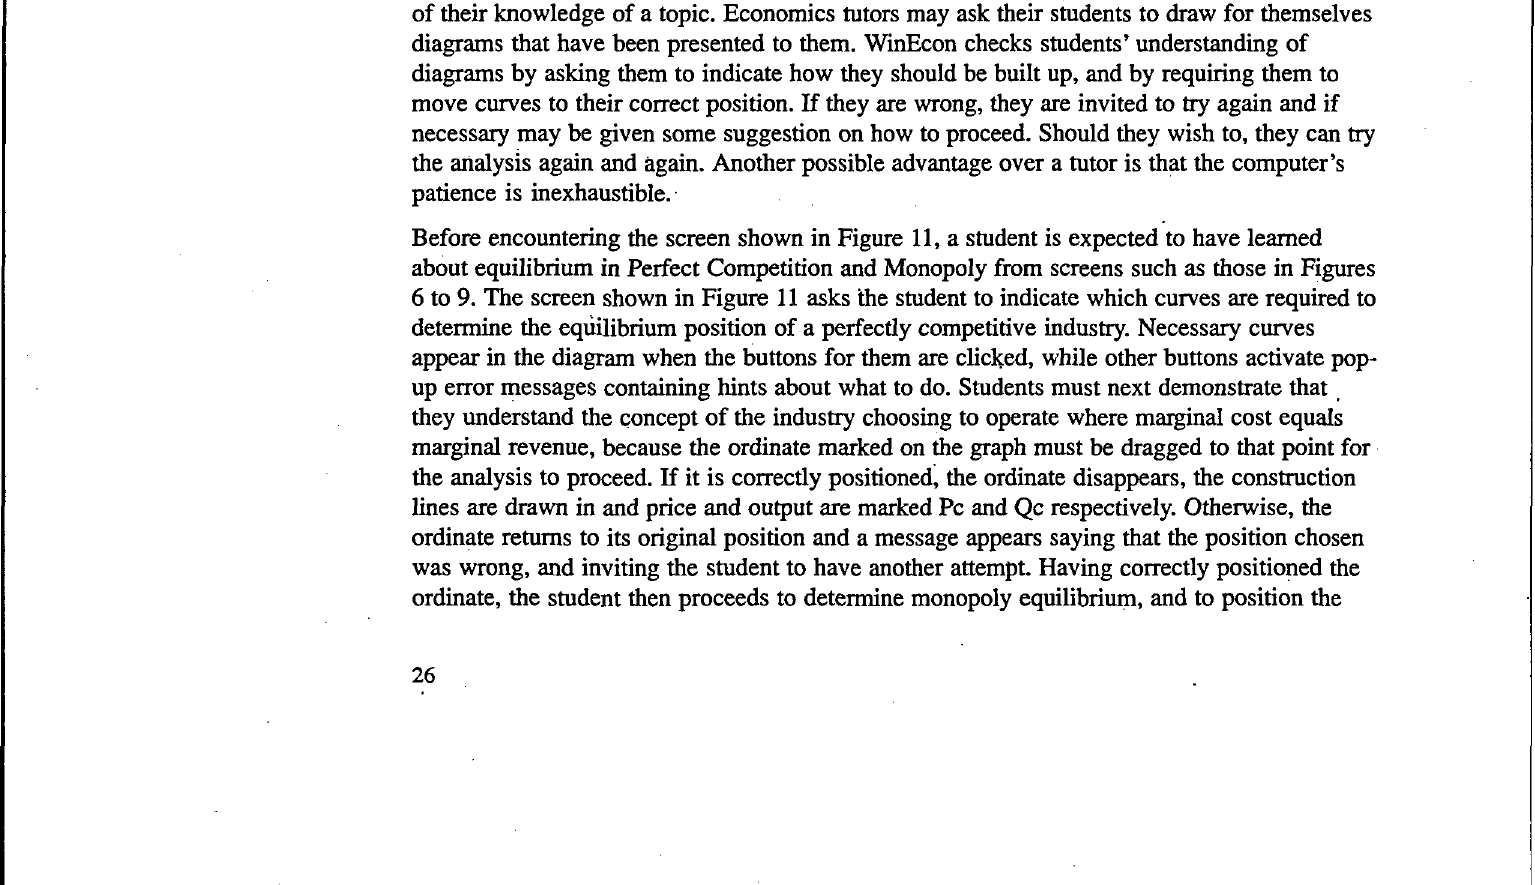
Figure 10: The menu of choices for the